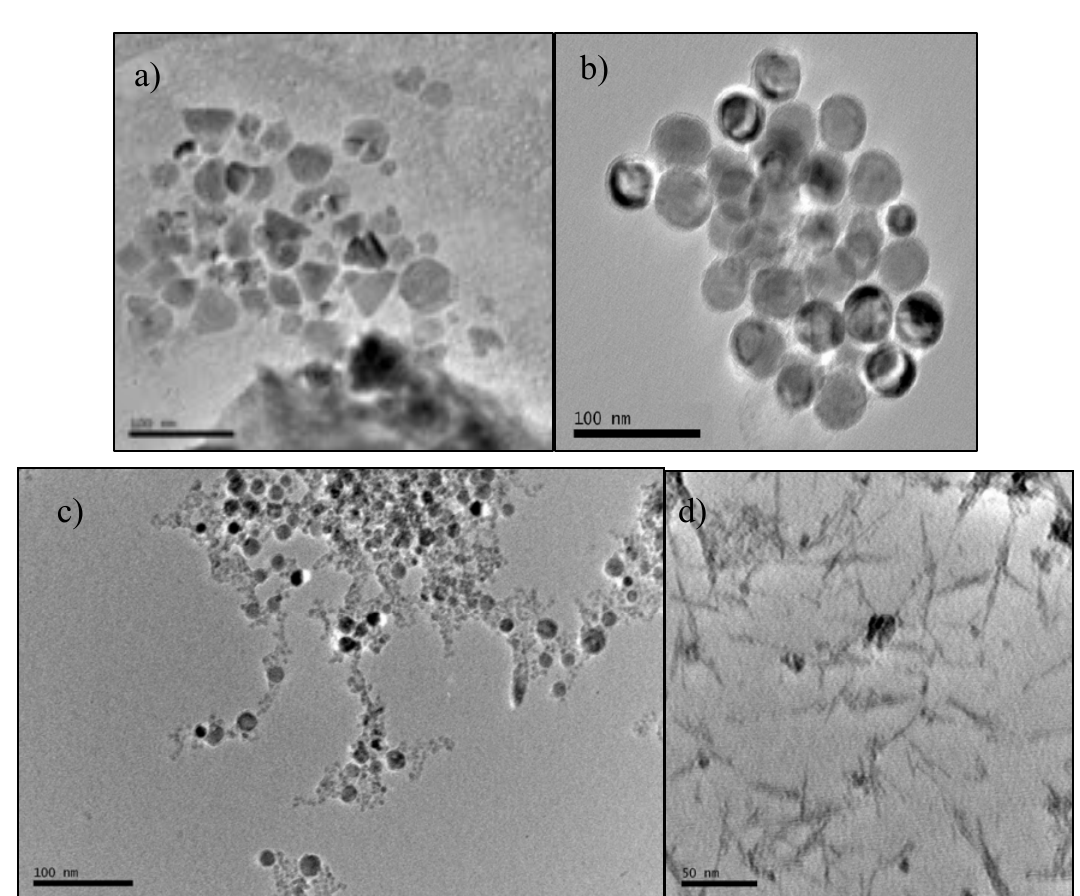
O nanocrystals prior to 3 4